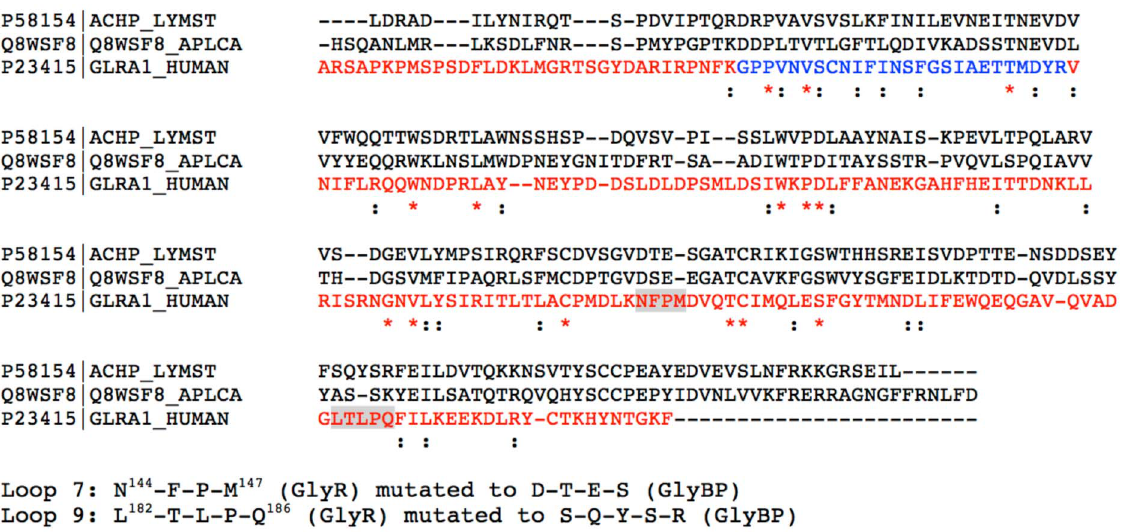
Figure 1. Coverage map and CLUSTAL 2.1 multiple sequence alignment (after manual adjustments described in [24] ) of L. stagnalis. A. californica, and the extracellular domain (ECD) of human glycine receptor alpha1 subunit. Loops 7 and 9 of GlyR ECD have been mutated to obtain GlyBP (grey highlights on the alignment). Sequence highlighted in red cumulatively marks peptides whose mass ions are detected in control studies. As described in the text, tryptic fingerprinting of GlyBP gel slices typically resulted in 55–80%